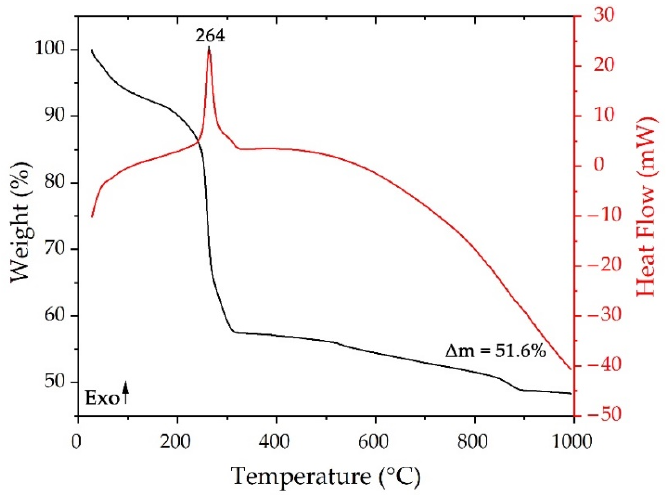
Figure 2. Results of synchronous (TGA/DSC) thermal analysis of the semiproduct.